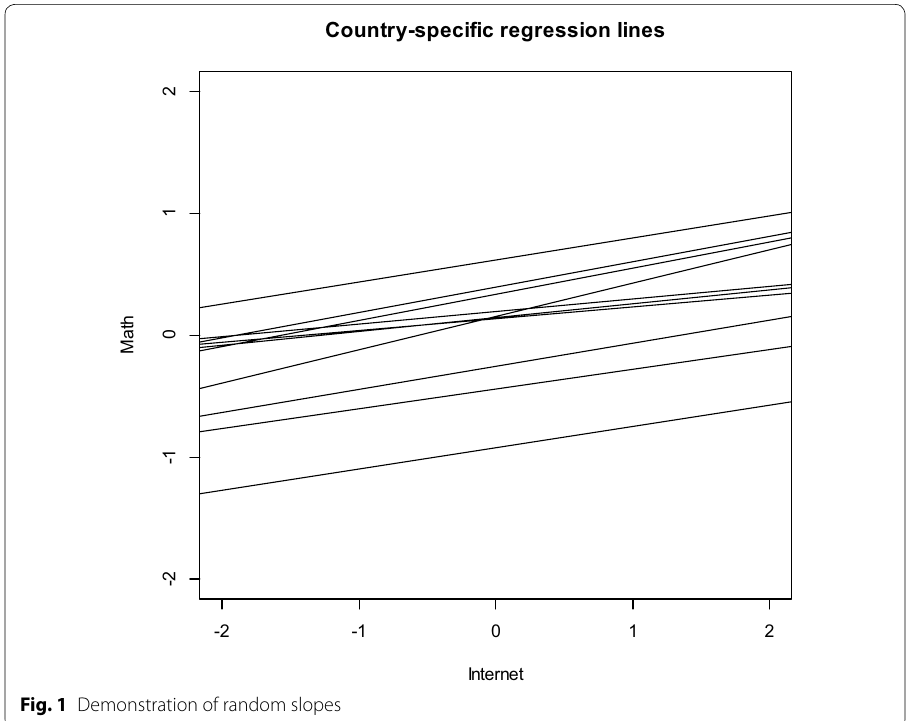
Fig. 1 Demonstration of random slopes